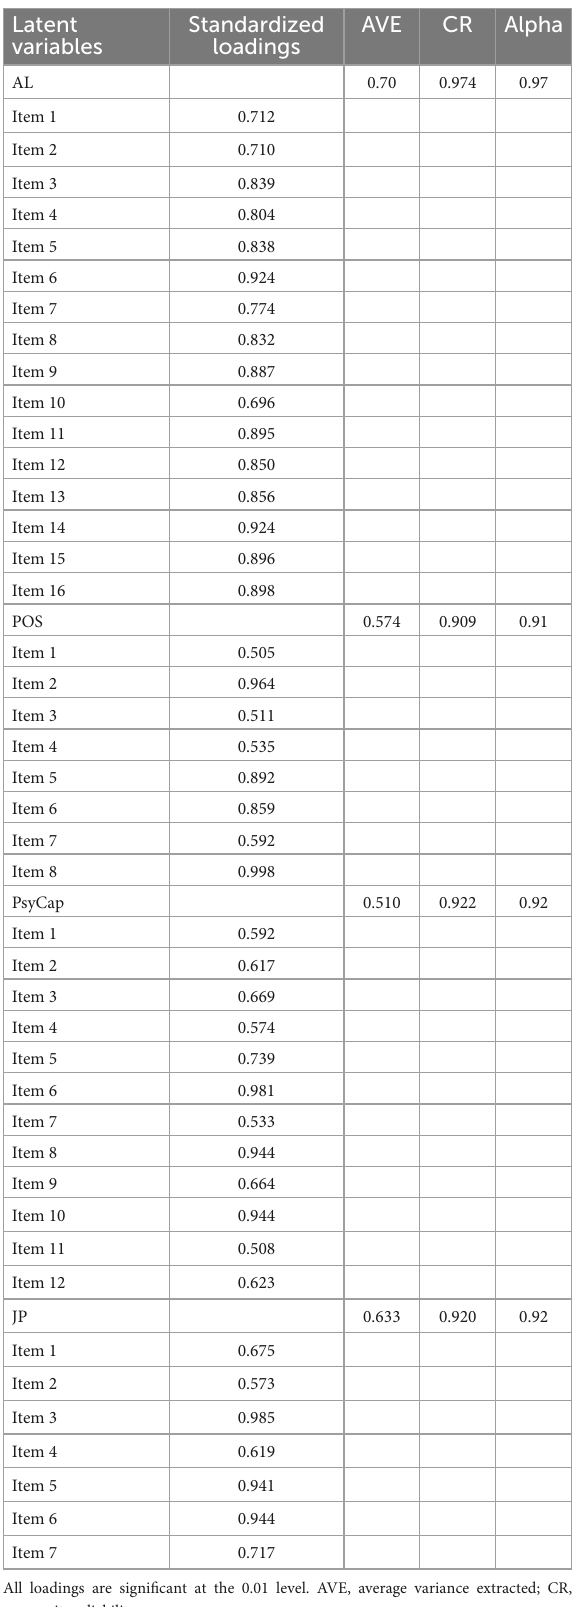
TABLE 1 Confirmatory factor analysis: validity and reliability.